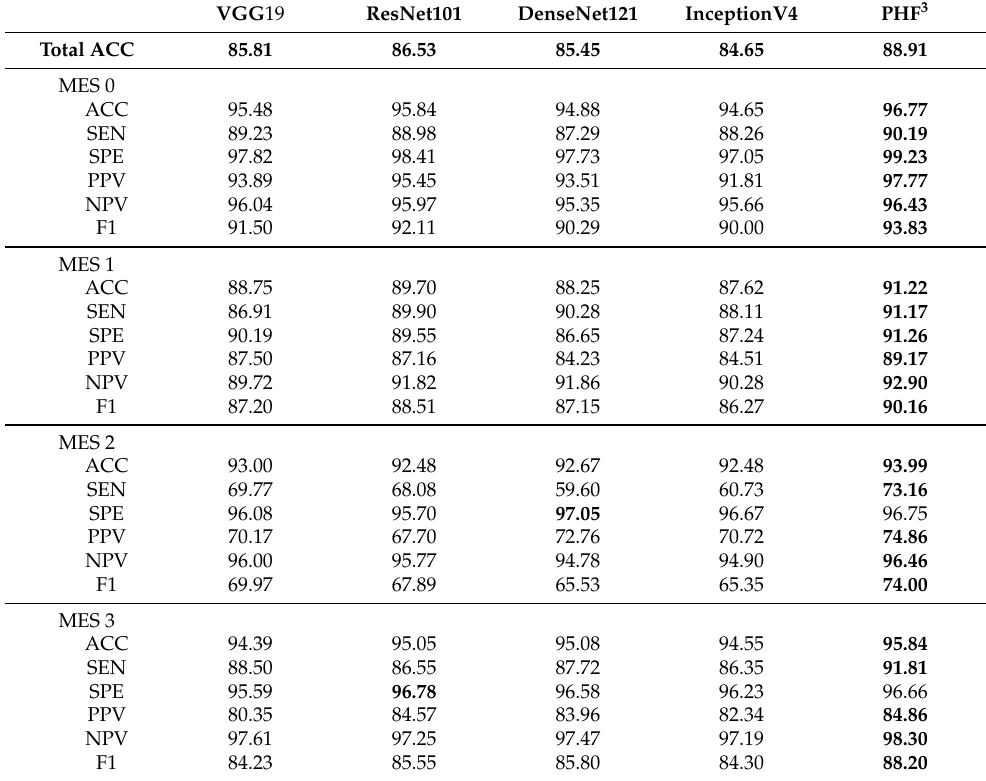
Table 5. Comparison of the proposed PHF 3 with some representative CNN